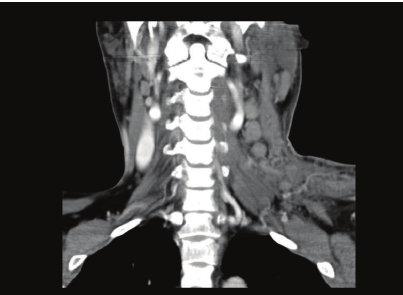
Figure 1: CT coronal reconstruction revealing the presence of diffuse left cervical lymphadenopathy.